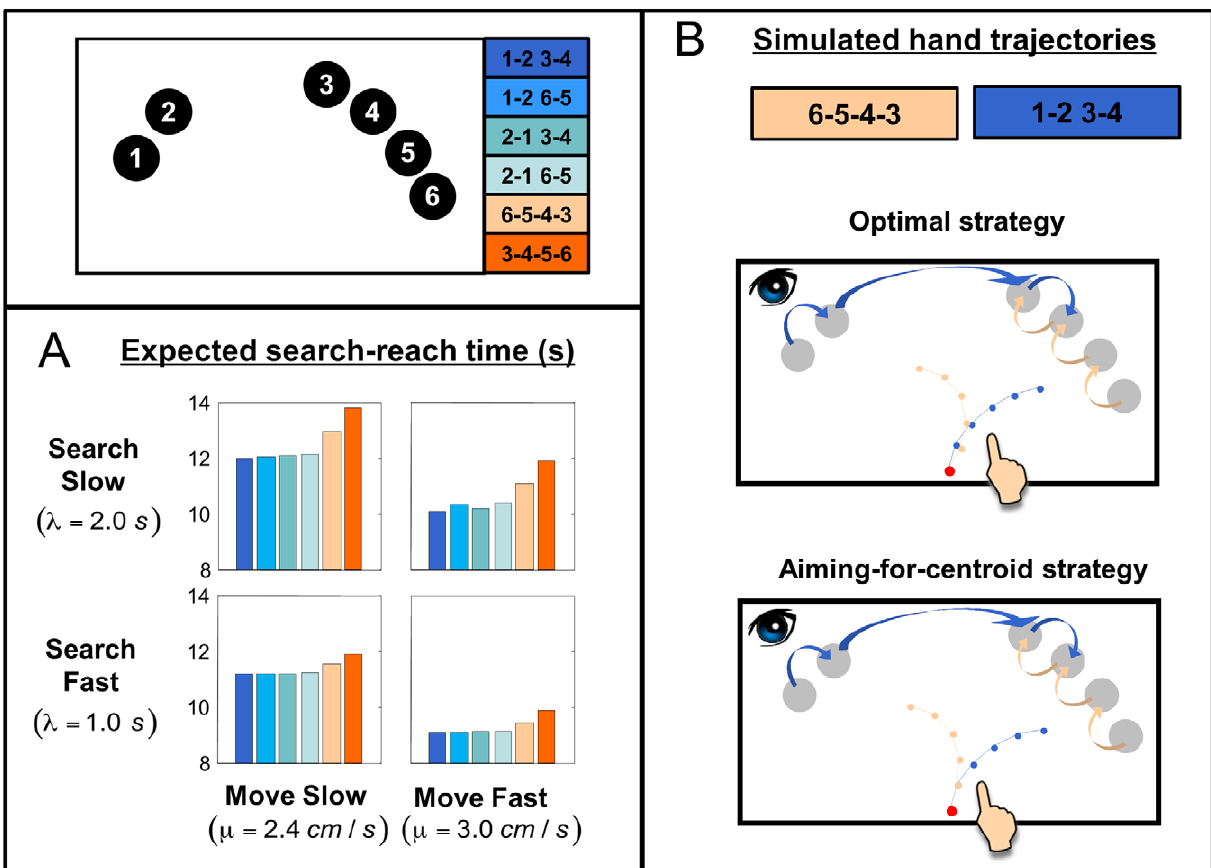
Figure 2. Optimal strategies of eye-hand coordination. A. Simulated expected search-reach time as a function of the order of search . Each panel is for a different search and hand movement capacity. The objects are numbered from 1 to 6 (inset). Orders of search are indexed with sequences of numbers. For instance, 12 34 denotes the sequence of fixations: object 1 first, then 2, then 3, then 4, and finally either 5 and 6 or 6 and 5 in either order. See text. Different colors denote different orders of search. We assumed that the observer always uses the optimal strategy of hand movement that minimizes her expected search-reach time under the specific order of search. The displayed ranges of search time per object, l , and hand movement speed, m , include those for human observers measured in the experiment. Whatever the search or movement speed of the observer, the search order 1234, i.e. starting from the end of the small cluster and moving continuously towards the large cluster, leads to the minimum expected search-reach time. But note that in the range of subjects’ visual search speed and hand movement speed, the difference between this optimal order and the other orders are larger when search is slower or hand movement is faster. The difference between 1234 and the other three orders starting from the small cluster (1265, 2134, and 2165) is negligible, but these four are obviously better than the two orders that start from the large cluster (6543 and 3456). For example, for a typical human observer (O7) with l ~ 1 : 4 s and m ~ 2 : 7 cm = s , the simulated expected search-reach time of 1234 is 10.3 s . The other three orders of small-cluster first cause an increase of less than 0.1 s , but the larger-cluster first orders, 6543 and 3456, would cost 0.7 s and 1.2 s more. Given the reward structure, using the latter two inferior search orders would lead to a loss of 6% and 12%, relative to the optimal one. B. Simulated optimal and close-to-optimal hand movement strategies . The hand trajectories are simulated for a typical human observer (Observer 07) with l ~ 1 : 4 s and m ~ 2 : 7 cm = s . Grey filled circles denote objects. The red filled circle at the bottom denotes the starting position of the finger. We illustrated the trajectories of optimal or close-to-optimal hand movement for two search orders, in different colors, blue for 1234, orange for 6543. Sequences of block arrows on the objects show the search orders. The lines originated from the starting position correspond to the trajectories of the finger. Each dot on a line marks the time when a new object gets identified. The optimal strategy for the hand (top) is the strategy that minimizes the expected search-reach time given a specific search order. The aim-for-centroid strategy (bottom) is to aim for the centroid of the objects that are still unidentified. The differences between the two panels are subtle. If the observer updates her movement aim after the identification of each new object, the expected search-reach time is almost the same as that of the optimal strategy.